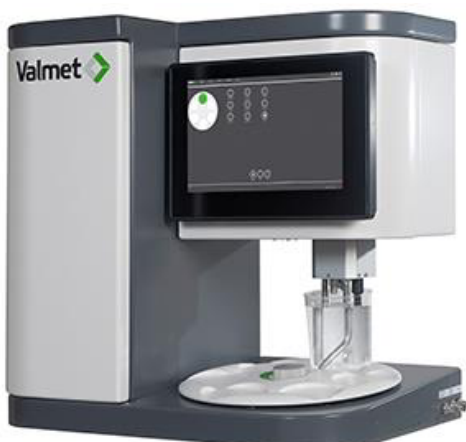
Fig. 1. Valmet Fiber Image Analyzer (Valmet